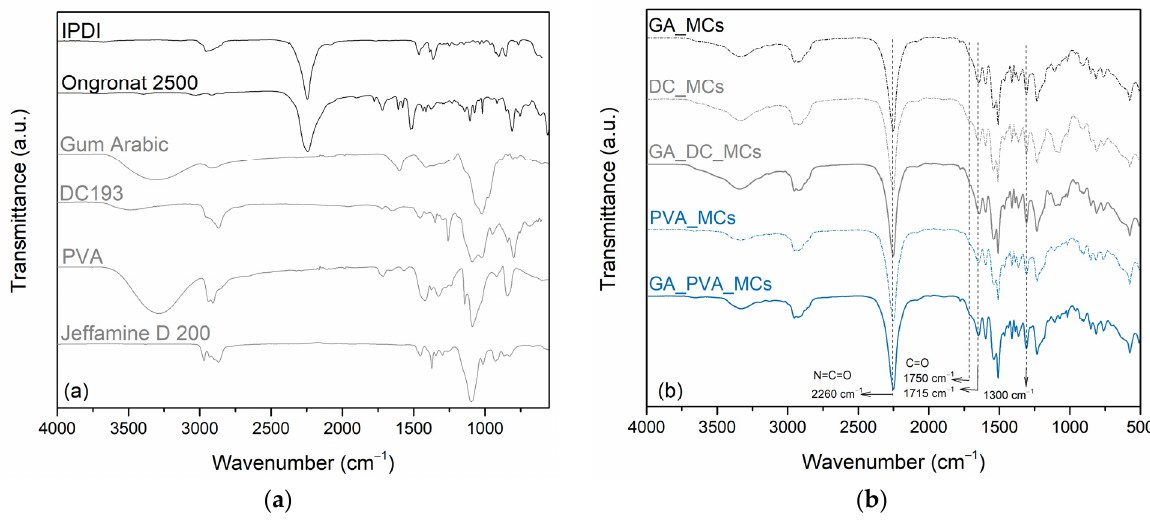
Figure 6. FTIR spectra of the isocyanates, active H source, and stabilizers ( a ). FTIR spectra of the MCs ( b ). Table 3. Mass loss (%) of encapsulated IPDI (by TGA), relative encapsulation Yield (Y) calculated using the FTIR spectra obtained after the synthesis and 3 months later. The Y obtained after the synthesis was calculated using (Equation (2). Y 3 is given as a percentage of